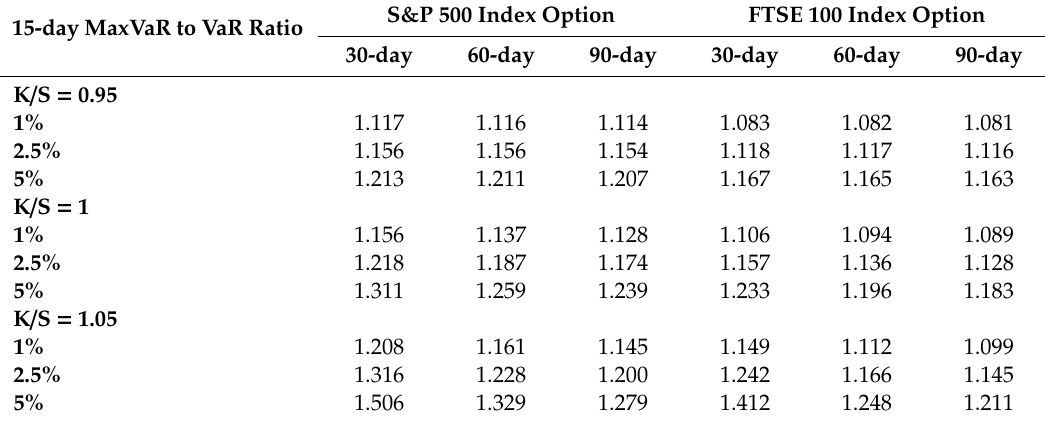
Table 10. Variation in 15-day Inflation factor with respect to moneyness of the